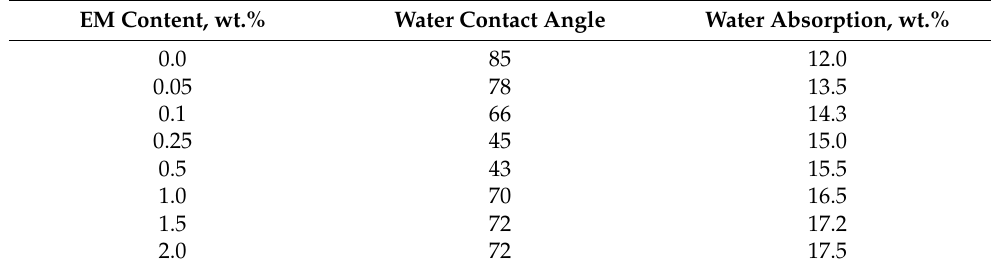
Table 1. Water contact angles and water absorption of AEBA-EM-PU at various EM content. EM Content, wt.% Water Contact Angle Water Absorption, wt.%